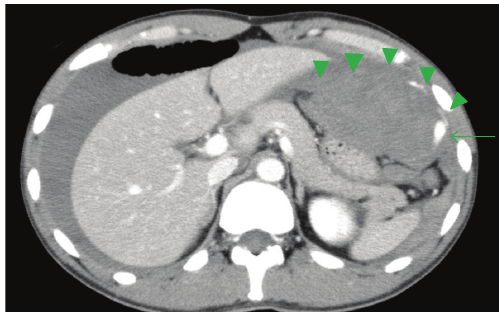
Figure 1: Abdominal enhanced CT revealed a hematoma (arrows) with extravasation (arrowheads) located in the left part of the omentum and relatively high-attenuation fluid in the abdominal